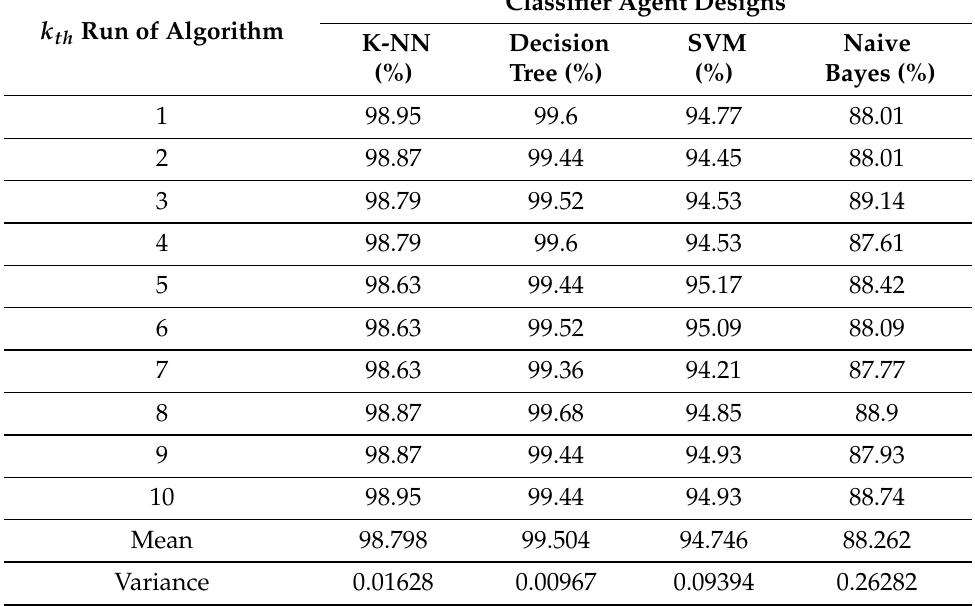
Table 3. NTCA classification accuracy.